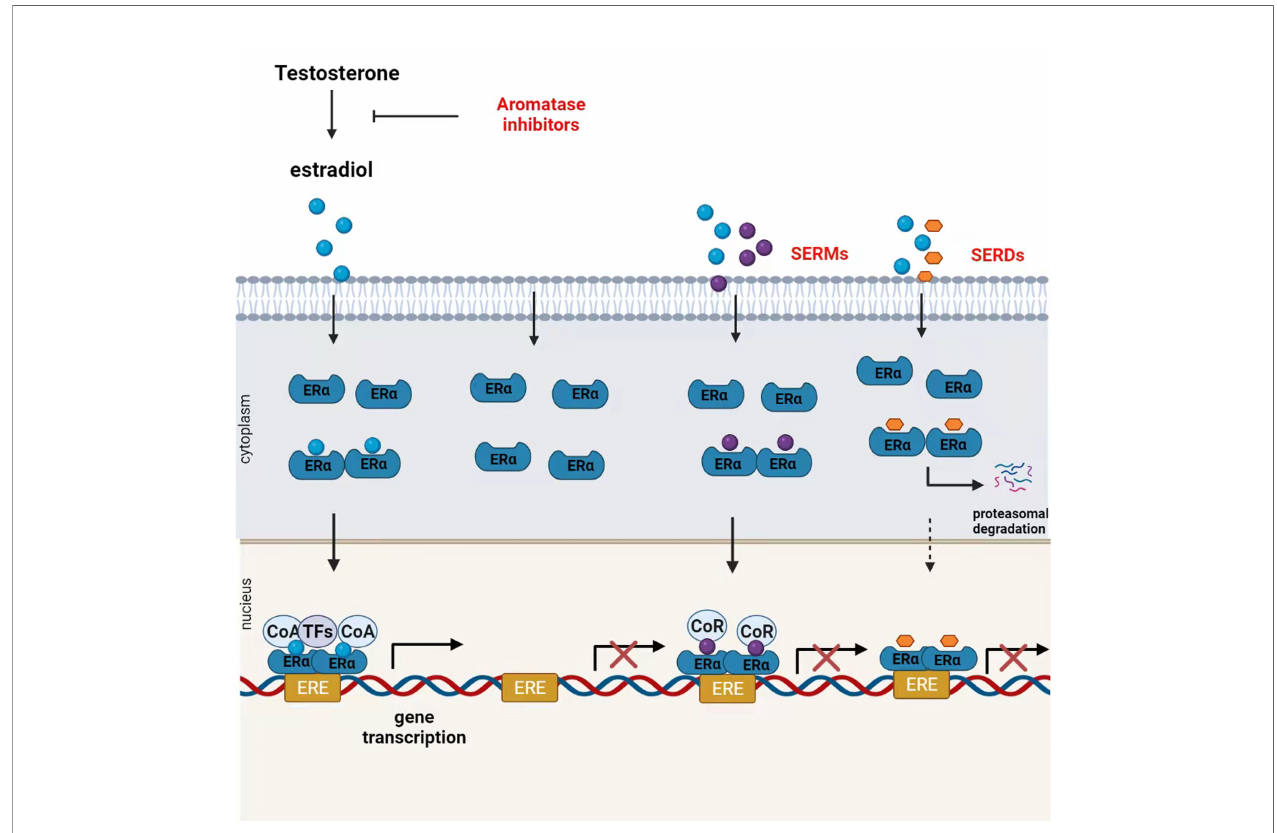
FIGURE 2 | Mechanism of action of endocrine therapies. Ovaries, the adrenal gland, and other organizations produce testosterone that is transformed into estradiol by aromatase. In the presence of circulating estrogen, estrogen receptor (ER) a undergoes conformational changes, form homo- or heterodimers and then migrates to the nucleus, where ER a dimers bind coactivators (CoA) to form a transcriptionally active ER a complex. ER a complex can regulate the transcription and activation of various genes by binding to the estrogen response element (ERE)-encoding gene or interacting with other transcription factors. Aromatase inhibitors block estrogen production by inhibiting androgen conversion to estrogens. Selective estrogen receptor modulators (SERMs) competitively inhibit the binding of estrogen to ER a . SERM-bound ER dimers bind to co-repressors (CoR) inhibiting ER transcriptional activity in breast cancer tissues. Selective estrogen receptor downregulators (SERDs) downregulate the receptor protein expression by inducing ER